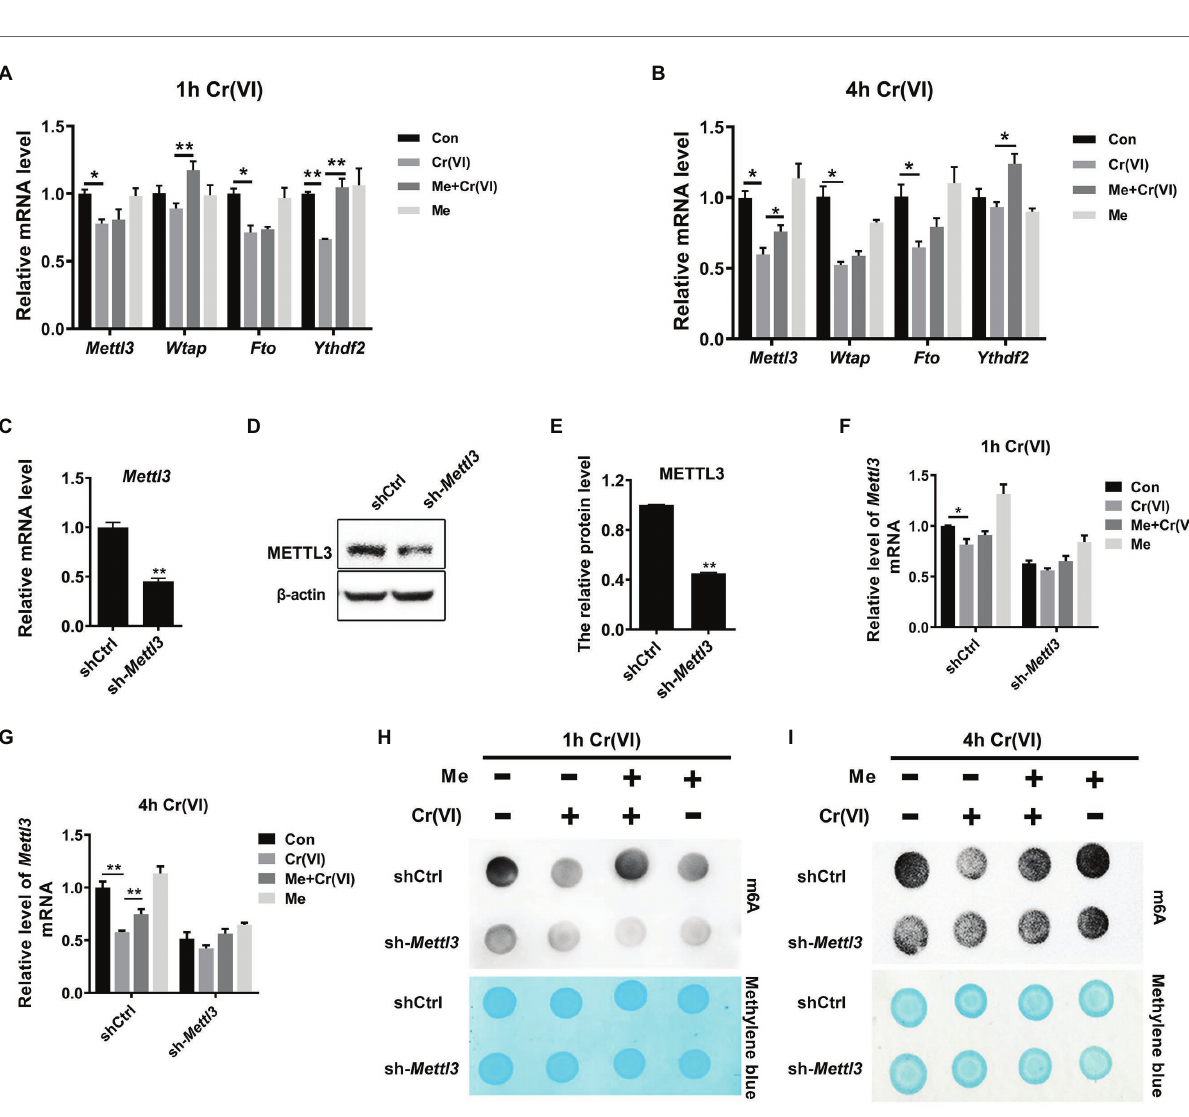
FIGURE 7 | the control, Cr (VI), melatonin + Cr (VI), and melatonin-treated SSCs/progenitors. Of these, Cr (VI) treatment lasted for 4 h. β -actin is used as a loading control. (F) The relative band intensities of Beclin1, p-Beclin1, and LC3-II in different cell treatment groups. (G) Mito and Lyso Tracker co-staining analysis in the control, Cr (VI), melatonin + Cr (VI), and melatonin-treated SSCs/progenitors. Bar = 2 μ m. (H) The ratios of double staining cells to Mito Tracker staining cells in the control, Cr (VI), melatonin + Cr (VI), and melatonin-treated SSCs/progenitors. (I) Western blot analysis of Tom20 in the control, Cr (VI), melatonin + Cr (VI), and melatonin-treated SSCs/progenitors. Of these, Cr (VI) treatment lasted for 4 h. β -actin is used as a loading control. (J) The relative band intensities of Tom20 in different cell treatment groups. (K) The m 6 A dot-blot assay showing the global RNA m 6 A modification levels in the control, Cr (VI), melatonin + Cr (VI), and melatonin-treated SSCs/progenitors. Of these, Cr (VI) treatment lasted for 1 h. Methylene blue is used as a loading control to eliminate the difference in mRNA amount. (L) The m 6 A-IP-qPCR analysis showing the relative m 6 A abundance in mitochondrial fusion genes Mfn2 , Opa1 and in mitophagy genes Bnip3 , Nix in the control, Cr (VI), melatonin + Cr (VI), and melatonin-treated SSCs/progenitors. Data are presented as the mean ± SEM of three independent experiments. * p < 0.05; ** p < 0.01.